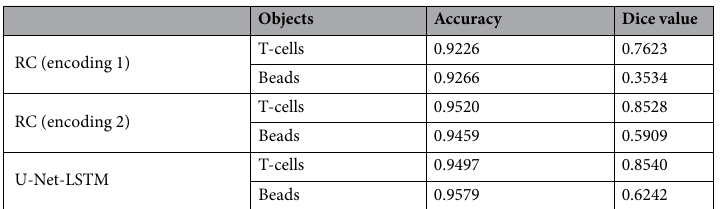
Table 3. Performance evaluation of the reservoir computing model and the deep learning models for task 2 (test set based on 1155 frames extracted from five Ca 2 + imaging sequences).